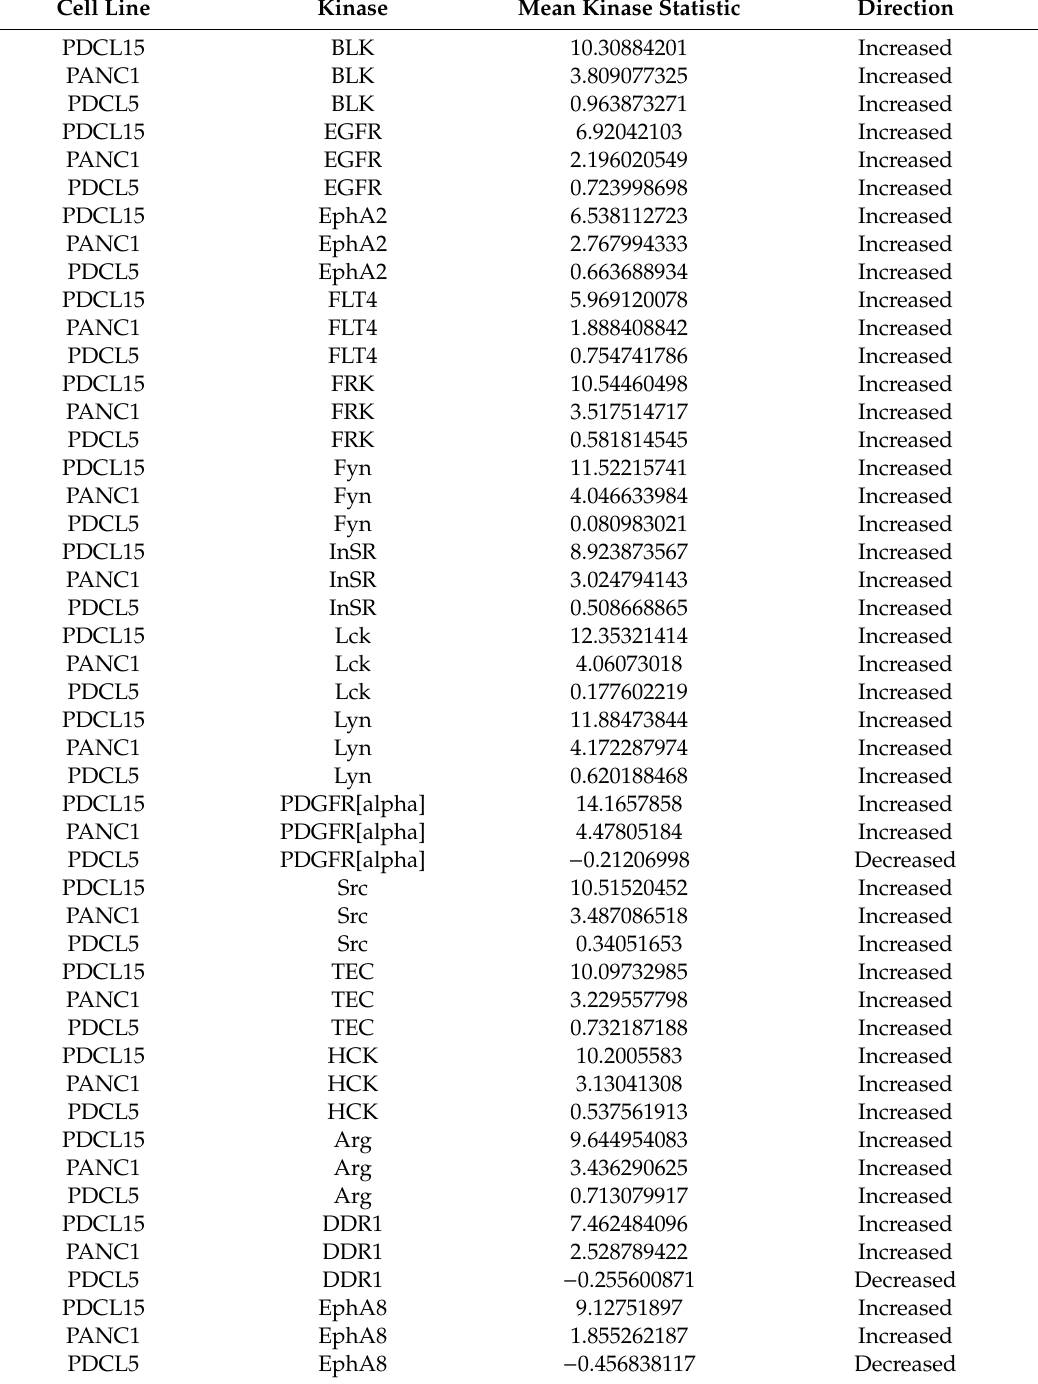
Table A1. UKA mean kinase statistic describes direction of di ff erential kinase